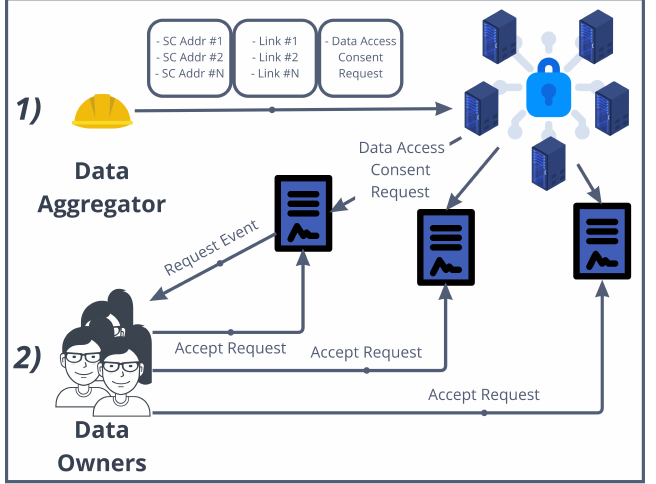
Figure 5. Example of the distributed access control where a data aggregator requests access to the data of some data